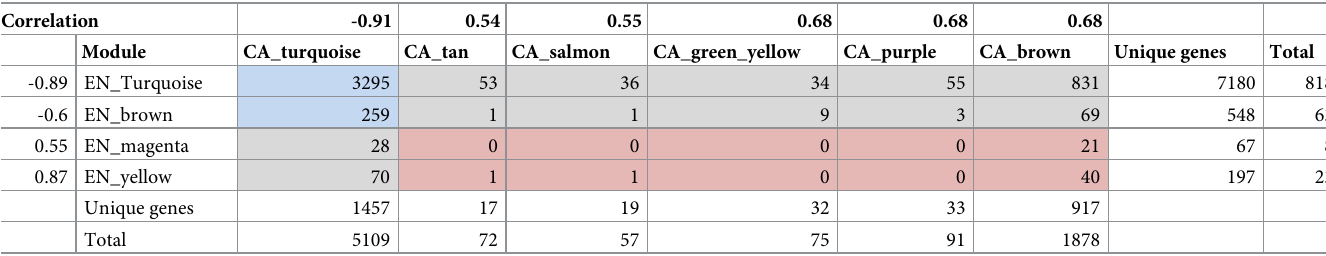
Table 3. Comparison of WGCNA expression by tissue and